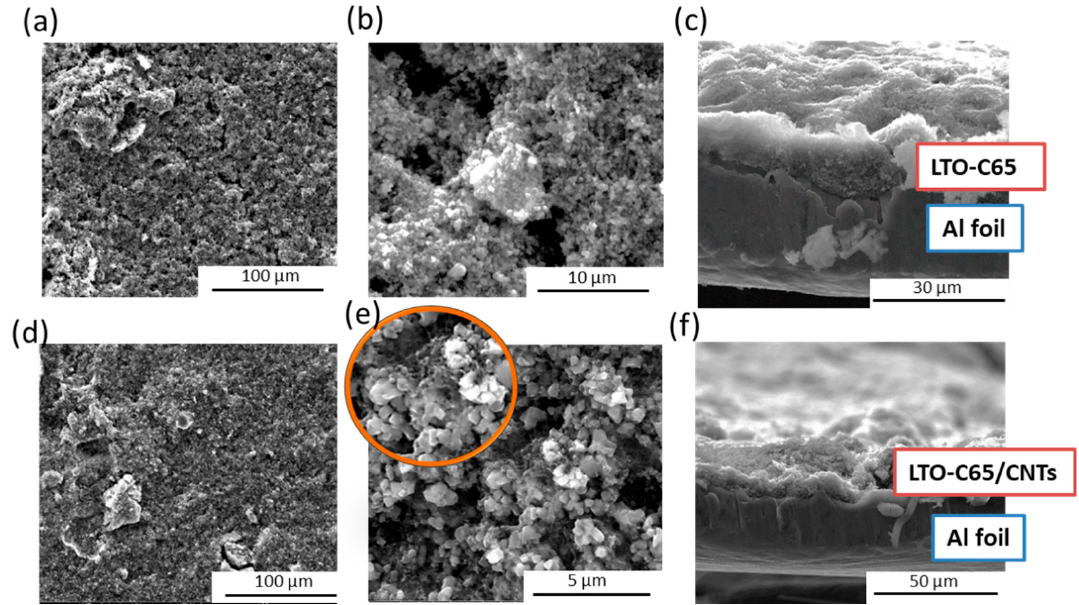
Figure 1. ( a – c ) Microscopical features of LTO-C65 and ( d – f ) LTO-C65/CNTs electrodes. Micrographs ( a , b , d , e ) correspond to top-views at different magnifications and ( c , f ) to cross-sections of the laminates.